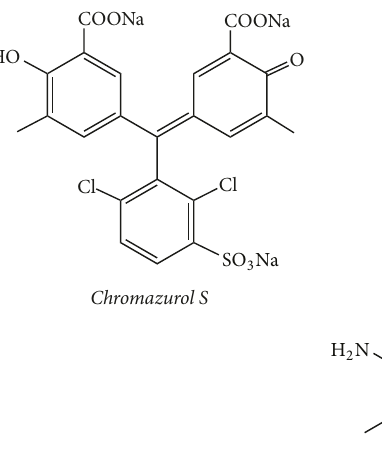
Figure 3: Molecular structure of investigated